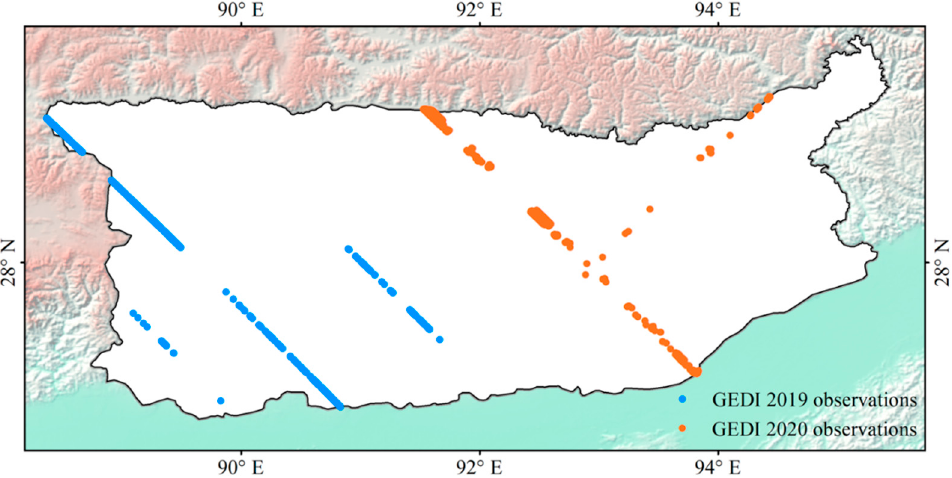
Figure 2. Distribution of GEDI observations acquired in 2019 and 2020 in the Eastern Himalayas.